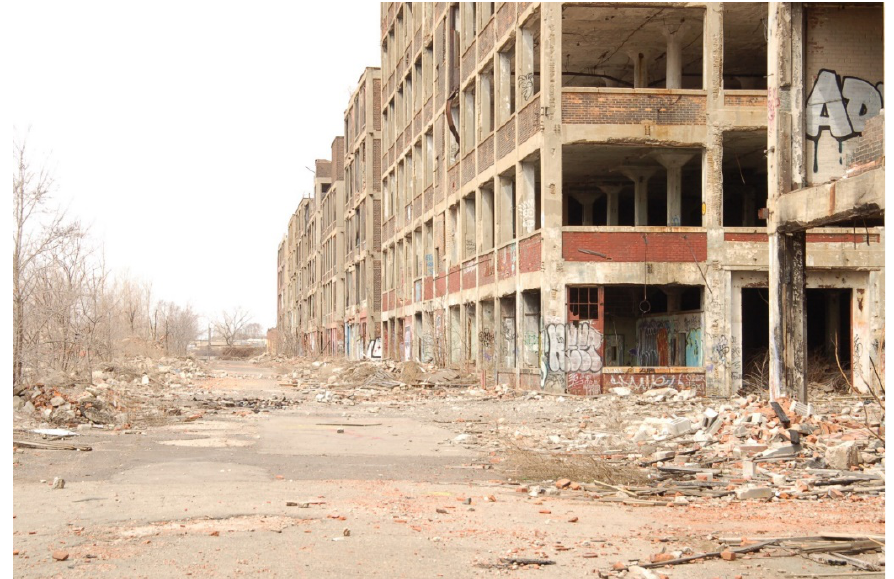
Figure 5. Packard Automotive Plant, Detroit, Michigan (Photo courtesy of Ball State University graduate architecture student Sandra